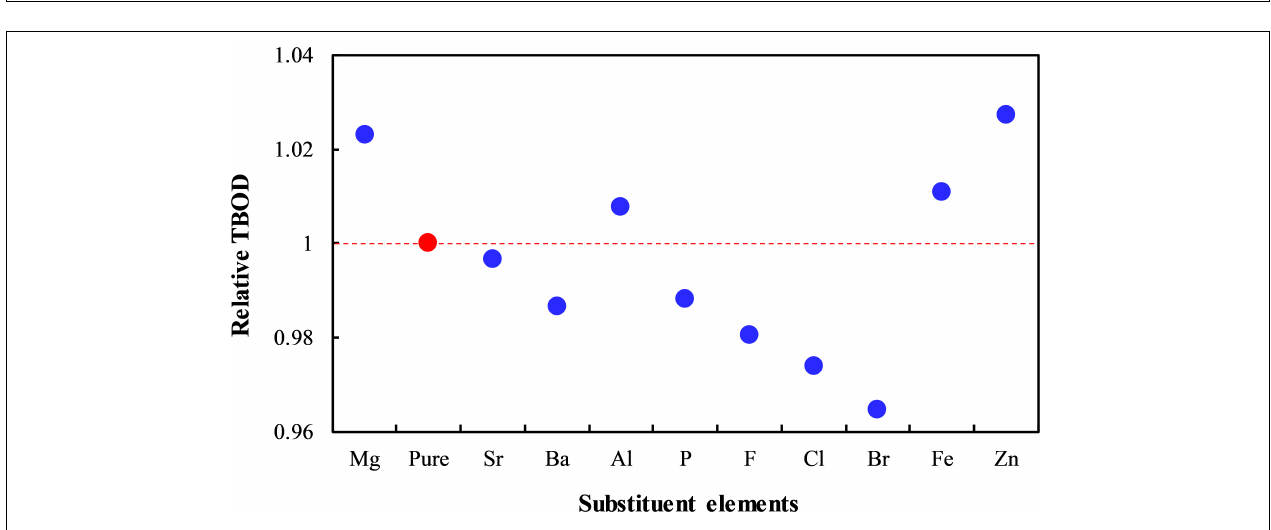
FIGURE 6 | Total bond order density of the doped γ -Ca 2 SiO 4 crystals relative to the pure γ -Ca 2 SiO 4 .